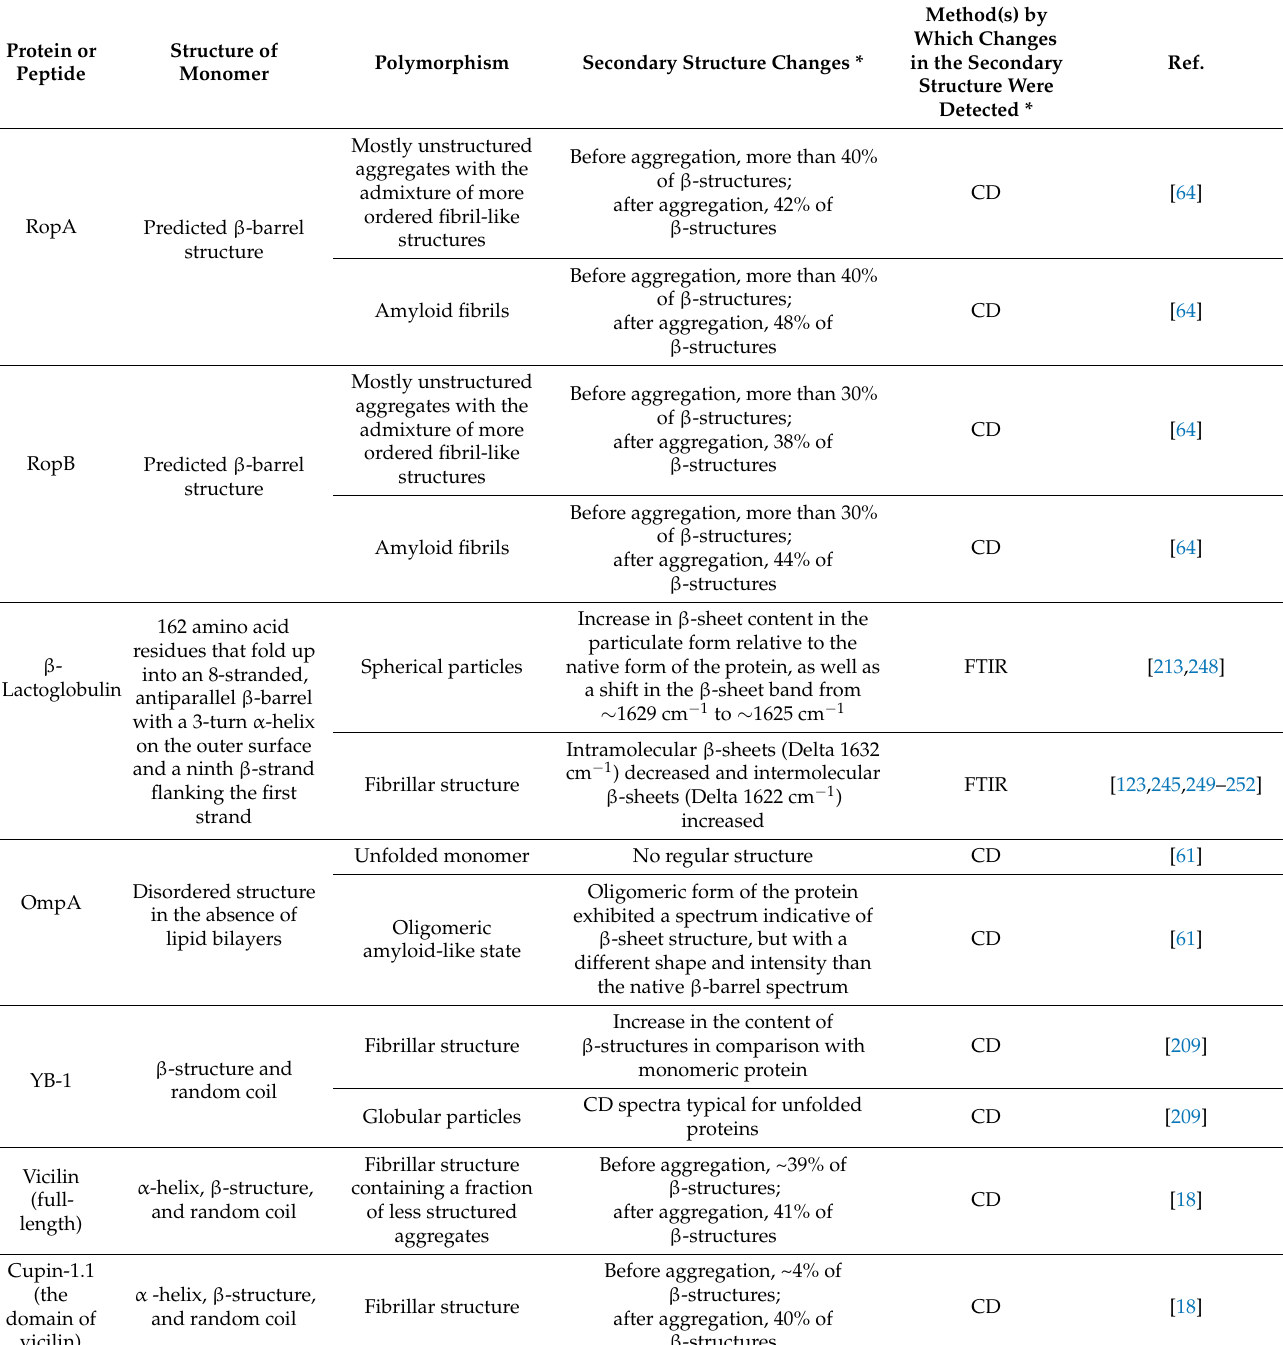
Table 2. Changes in the secondary structure of β -barrel proteins during amyloid